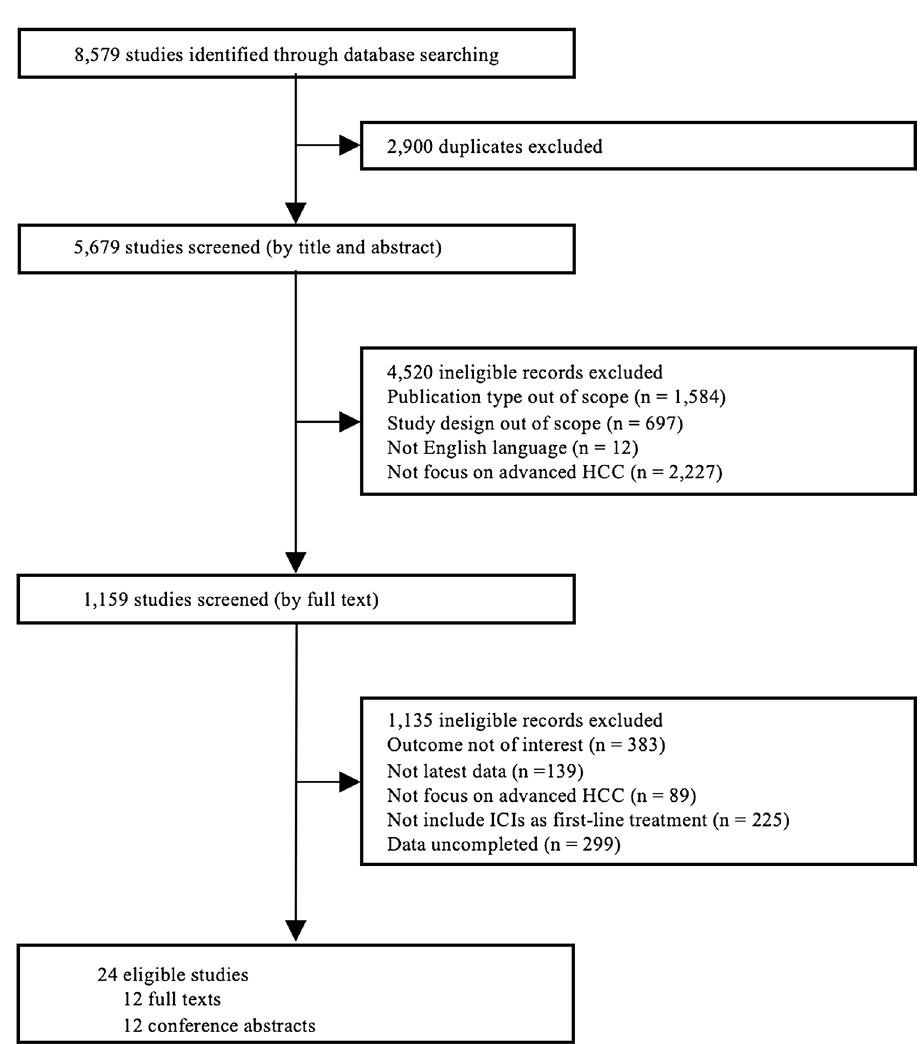
Fig. 1 PRISMA flowchart of study